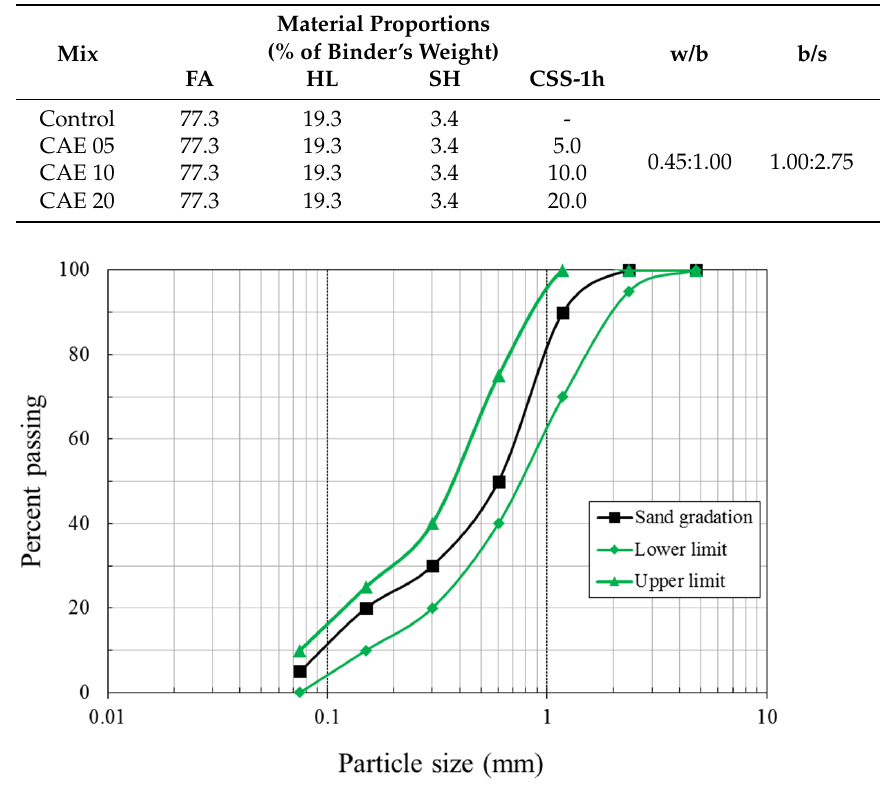
Figure 3. Sand gradation used for mortar samples.